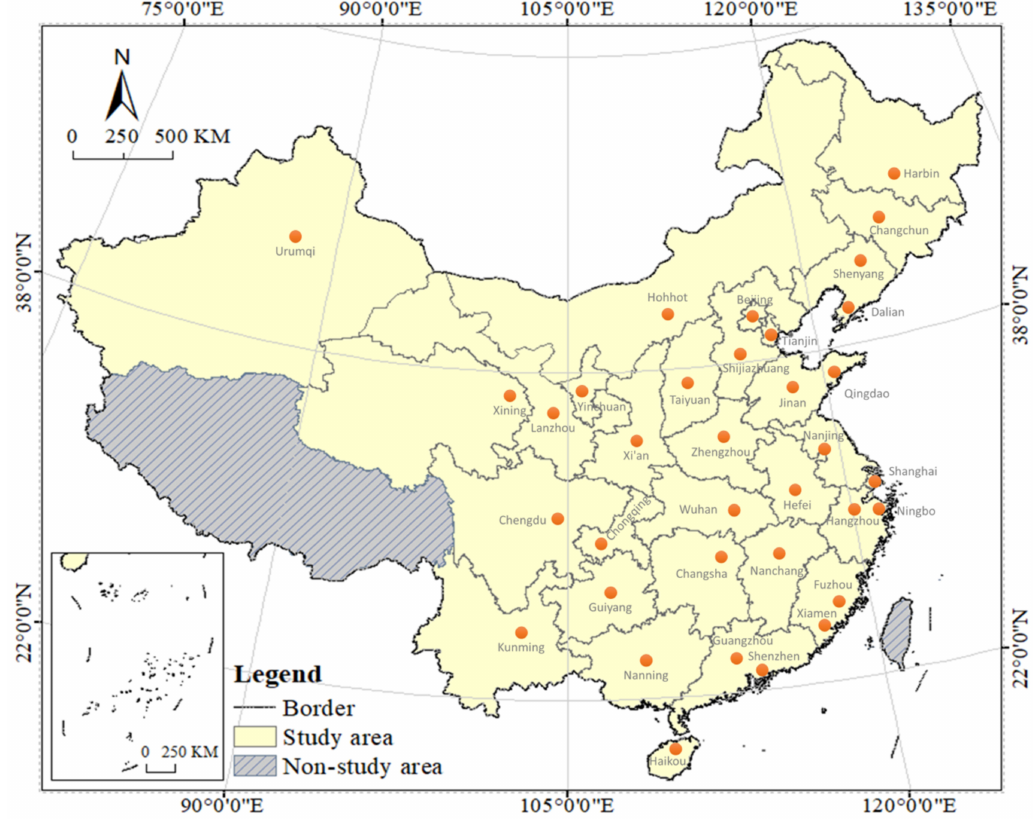
Figure 1. Study area. Table 1. Analysis on the inventory of real estate in the study